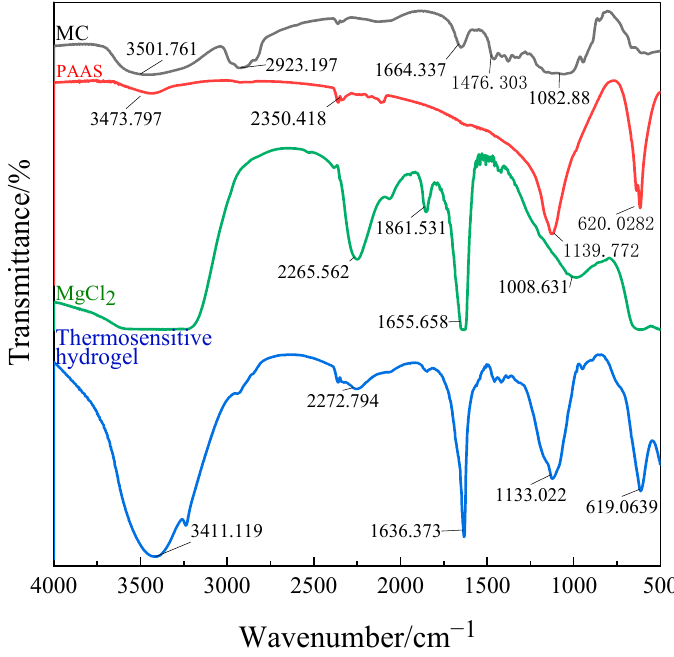
Figure 3. Infrared spectrogram of the thermosensitive hydrogel. A broad spectrum can be observed in the range of wave number 3600–3100 cm -1 (cor- responding to O-H oscillation). In pure MC, the peak at 3501 cm -1 is the stretching vibra- tion peak of the –OH bond, the strong and broad absorption peak here indicates that the hydroxyl group in MC has an association reaction. The C–H bond stretching vibration peak is at 2923 cm -1 and the C–O–C bond stretching vibration peak at 1082 cm -1 . It can be seen from the spectrum that the characteristic band of pure MC at 1476 cm -1 disappeared, and no new characteristic band appeared. All peaks are much weaker, indicating that a large number of hydrogen bonds are formed between MC, PAAS, and MgCl 2. The band at 3411 cm -1 narrows and shifts to the low-frequency range, demonstrating that a hydro- gen bond can be formed between MC and PAAS. The band vibration enhancement at 1636 cm -1 is the result of the superposition of the C=C stretching vibration absorption peaks in MC, PAAS, and MgCl 2 at the same place. In the spectrum of the thermosensitive hydrogel, the characteristic peaks of MC, PAAS, and MgCl 2 are all present, indicating that there is only physical cross-linking among the three components.